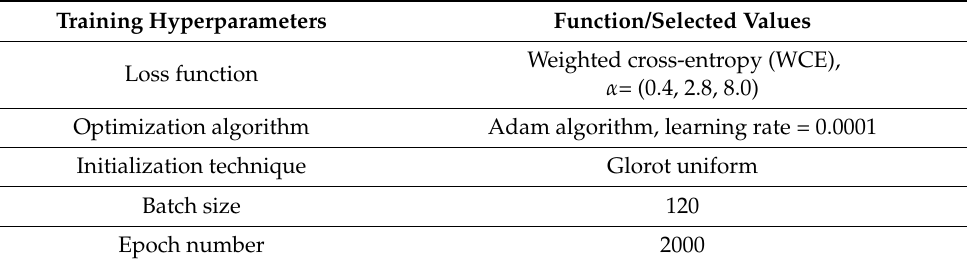
Table 5. RCNN hyperparameter settings.